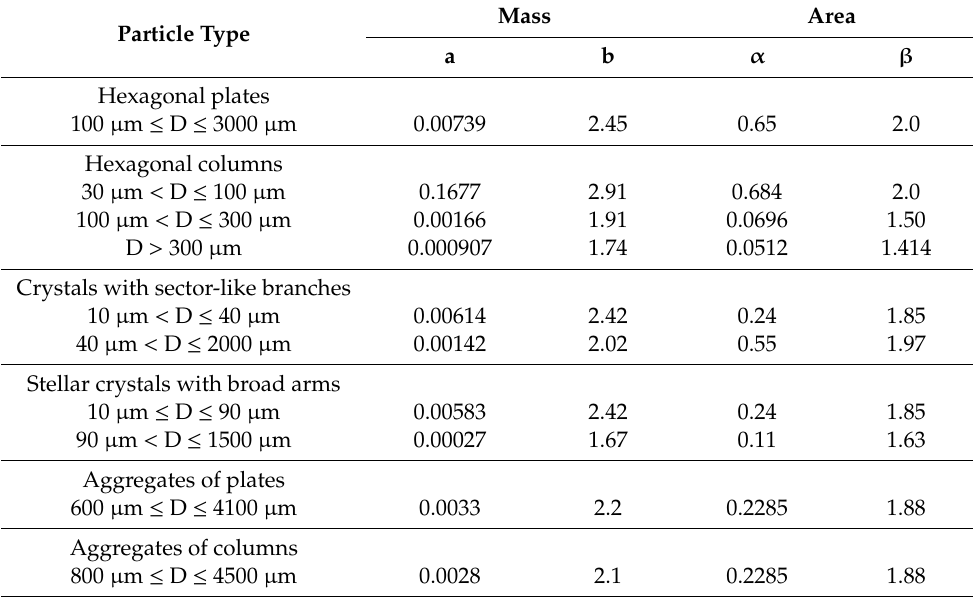
Table 2. Coe ffi cients of mass- and area-dimensional power laws for the six ice particle types. ( m = aD b , A = α D β , units are